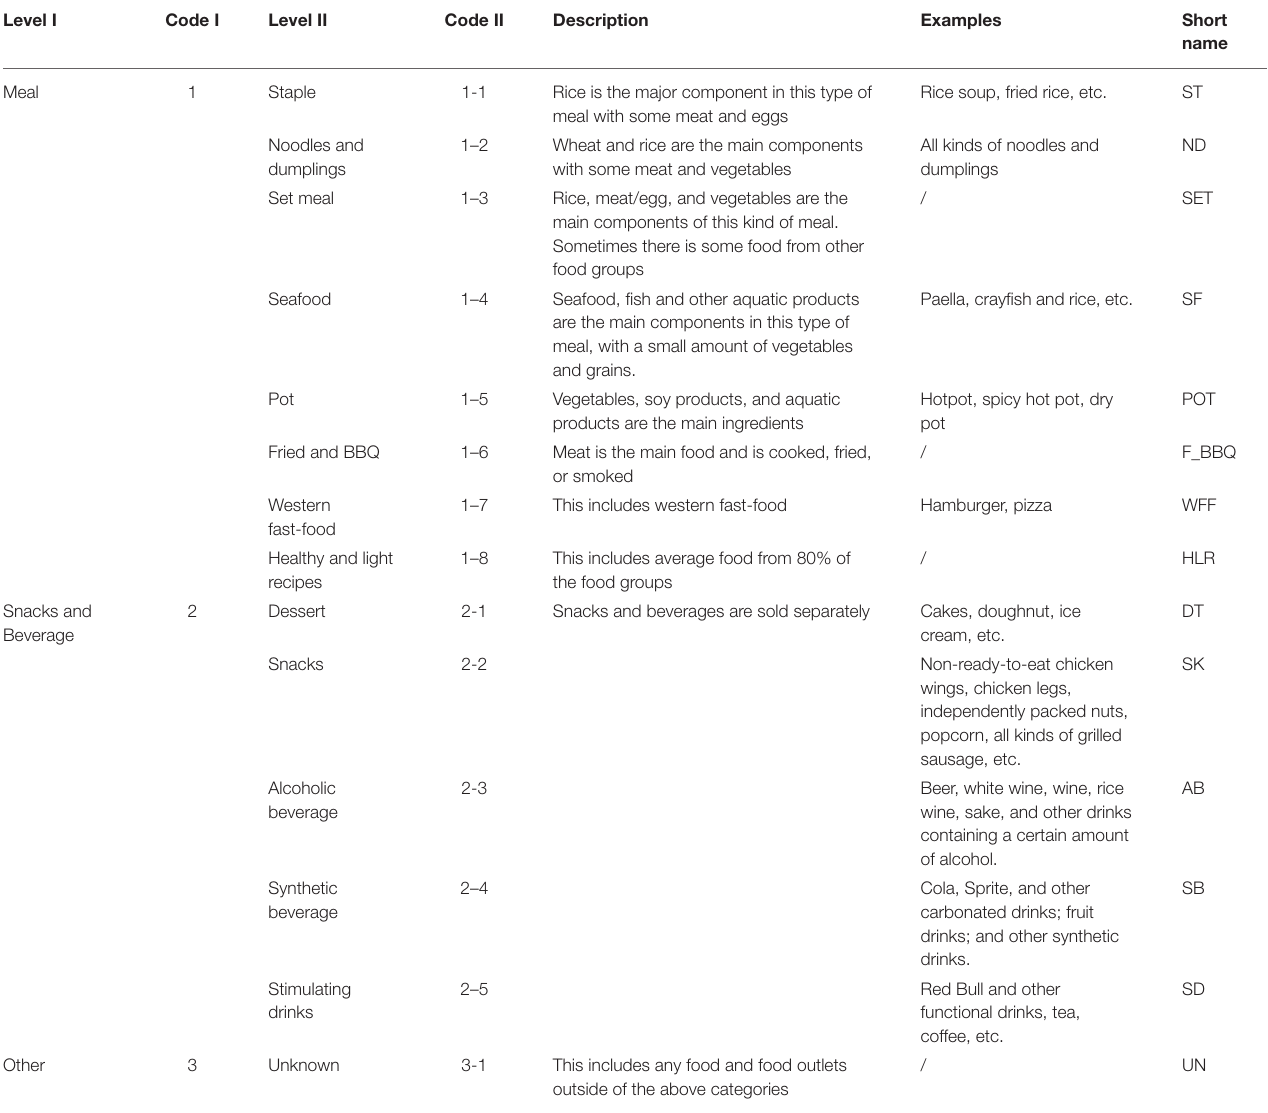
TABLE 2 | The classification system for food outlets and meals. Level